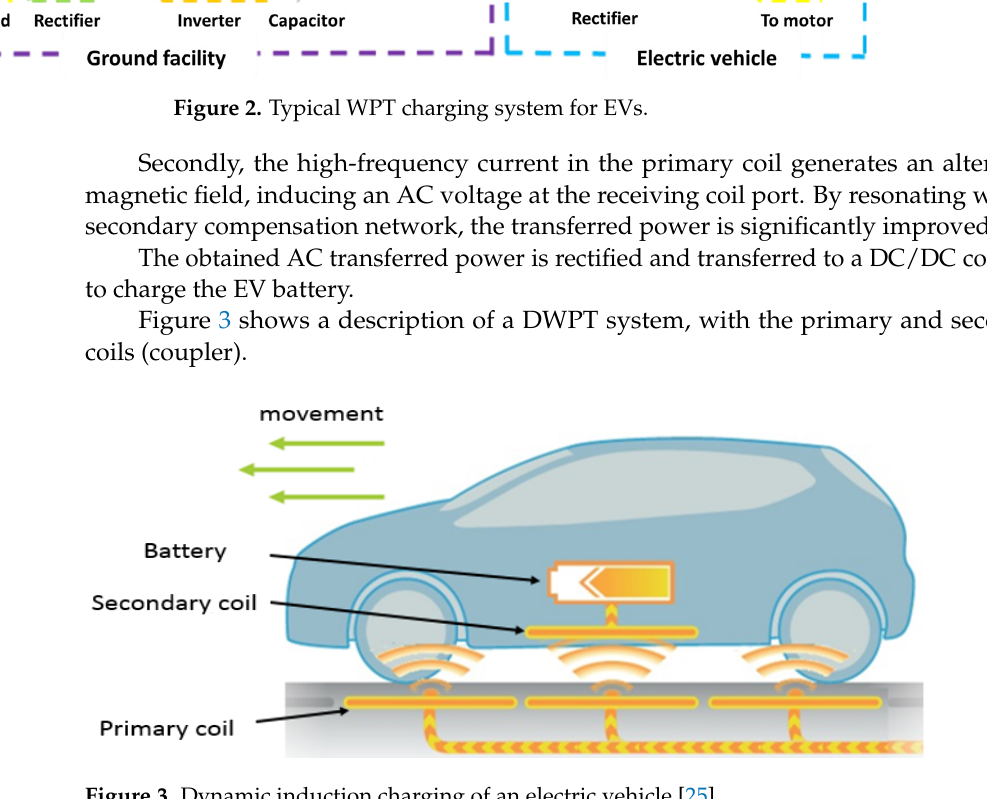
Figure 2. Typical WPT charging system for EVs.